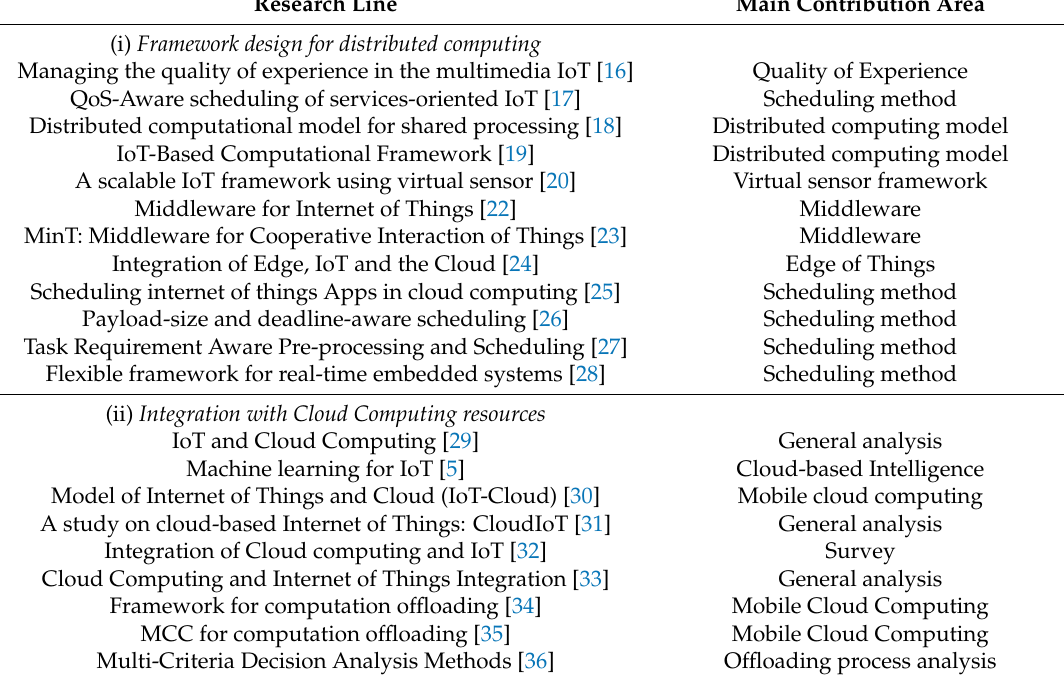
Table 1. Recent advances on IoT distributed